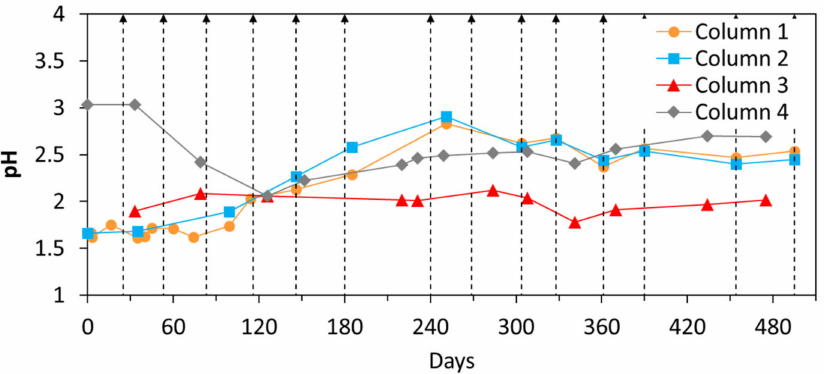
Figure 7. The pH measurements in the column leachates. Vertical dashed lines mark the beginning of each wetting-drying